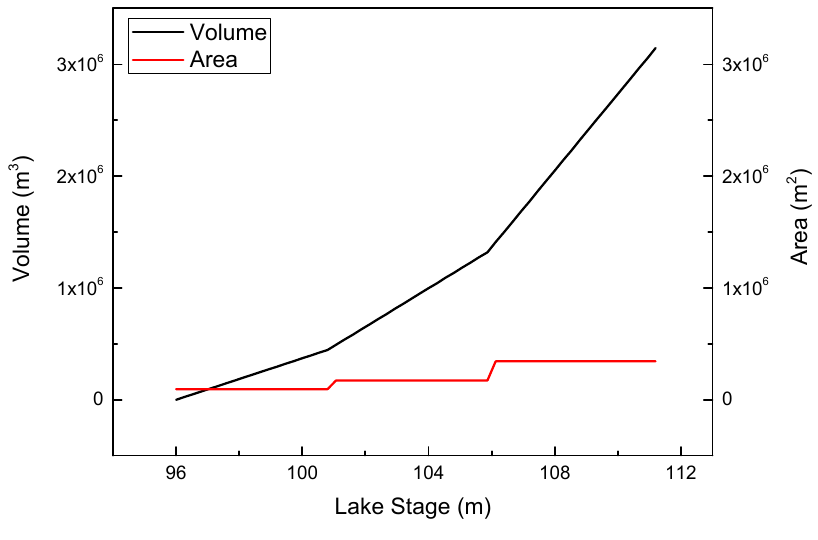
Figure 3. Depth–area–volume curves for the hypothetical